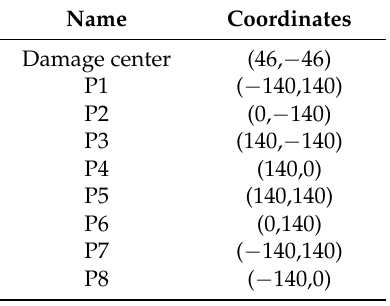
Figure 11. Photo of the composite laminates and sensing path of the sensor array. Table 2. Coordinates of the damage center and piezoelectrics